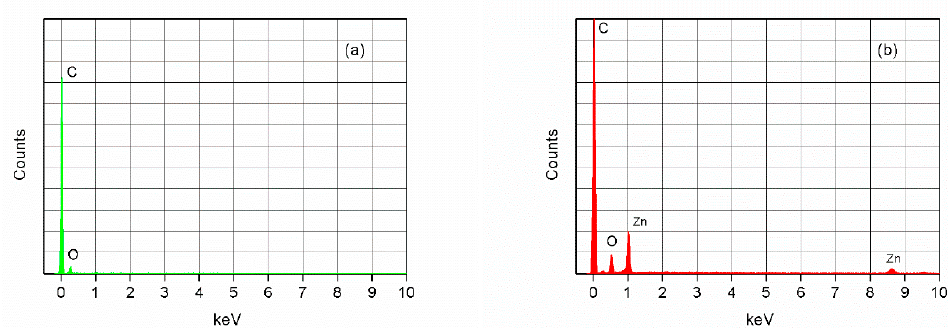
Figure 4. EDX spectra of the ( a ) uncoated wood (sample S1) and ( b ) epoxy@ZnO coated wood (sample S3).